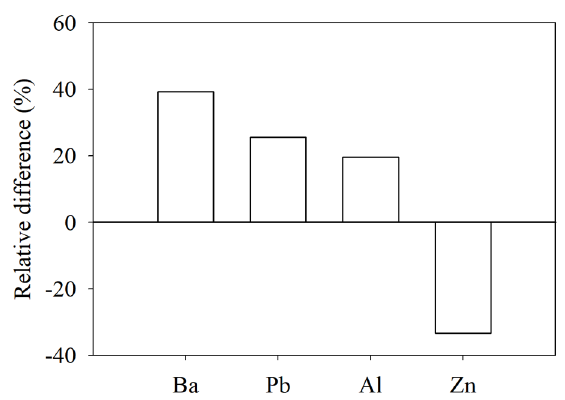
Figure 4 - Relative difference of Ba, Pb, Al and Zn content in Clone 1 compared to Clone 2